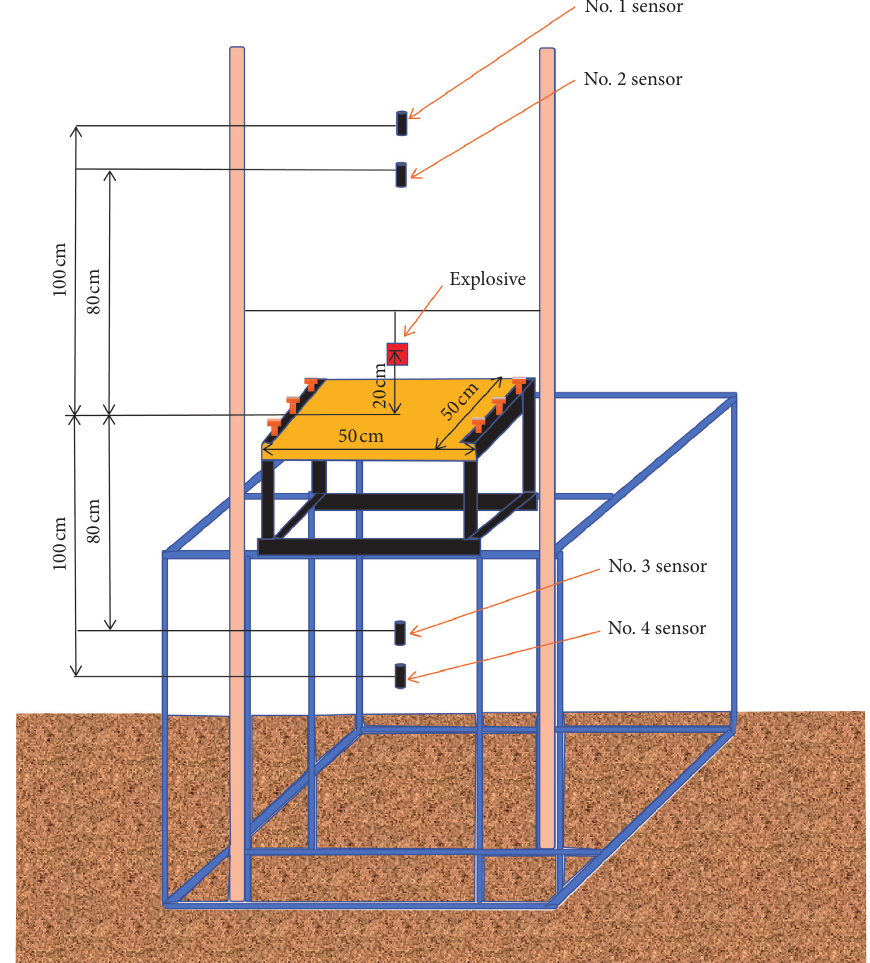
Figure 5: Simplified picture of the explosion experiment device. Table 1: Experimental